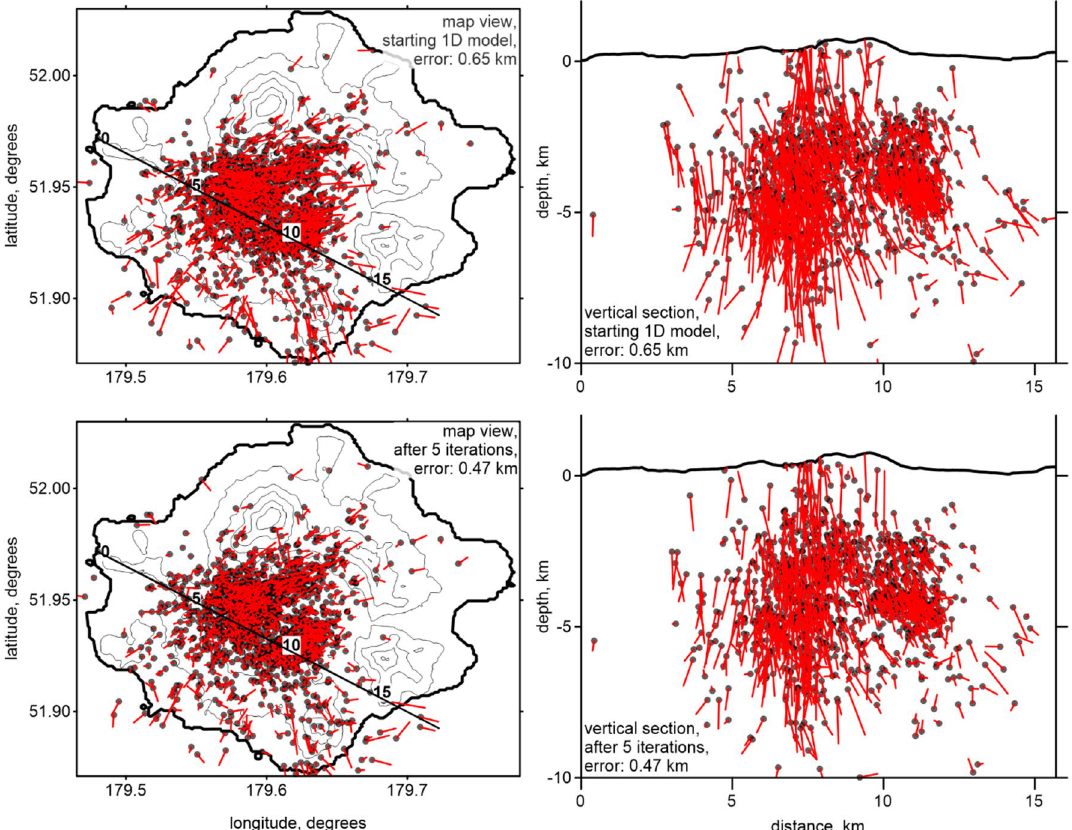
Figure 5. Mislocations of the sources during the synthetic modeling (for the model indicated in the right-hand column in Fig. 4) shown in map view and a vertical section. The upper row shows the location results using the start of the 1D model, and the lower row shows the location results of the final 3D velocity model. The black dots indicate the location of current events, and the red bars indicate the true locations. The mean errors of the source locations are indicated in the figure captions. The figure was generated using the software Surfer (version 13, http:// www. golde nsofw are. com/ produ cts/